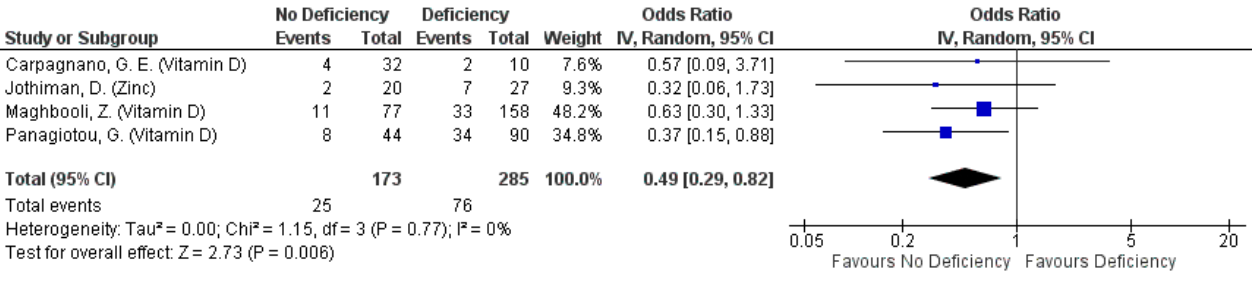
Figure 4. Pooled odds ratio on ICU admission due to COVID-19 episode when hospitalized subjects are not deficient, compared to those deficient in any micronutrient singly.